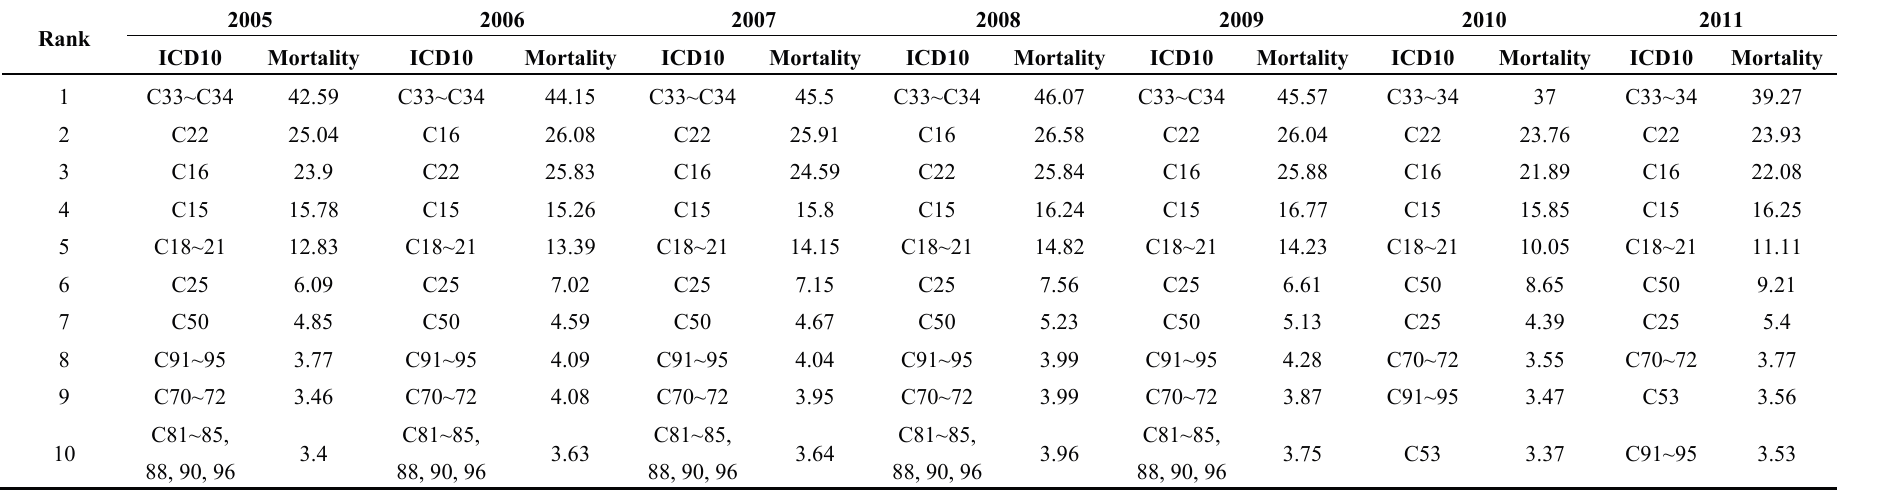
Table 4. Changes in the ranking of the top ten cancers for mortality in China,